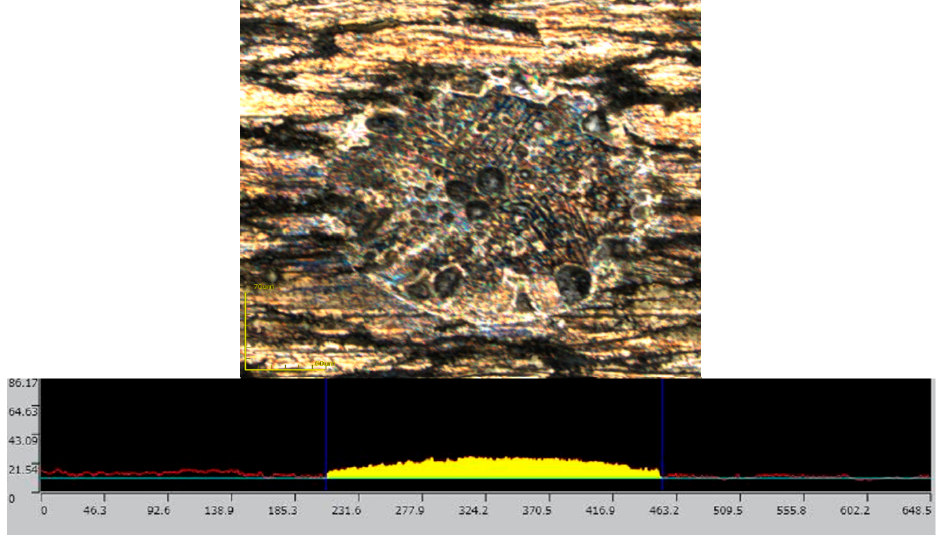
Figure 3. Photograph and view of the formation profile along the tube resulting from exposure to a laser pulse of I = 110 A, d = 240 µm.